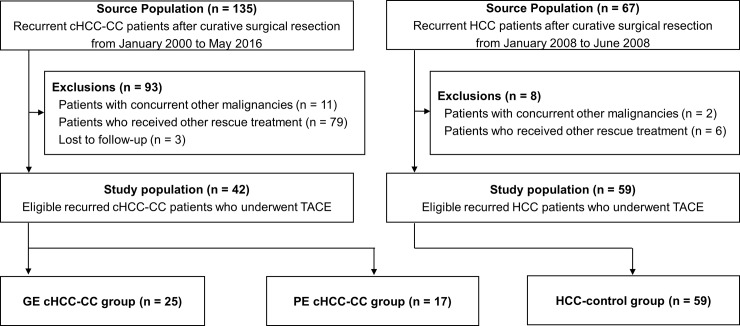
Patient flow diagram.cHCC-CC, combined hepatocellular-cholangiocarcinoma; GE, globally enhancing; PE, peripherally enhancing; TACE, transarterial chemoembolization; HCC, hepatocellular carcinoma.